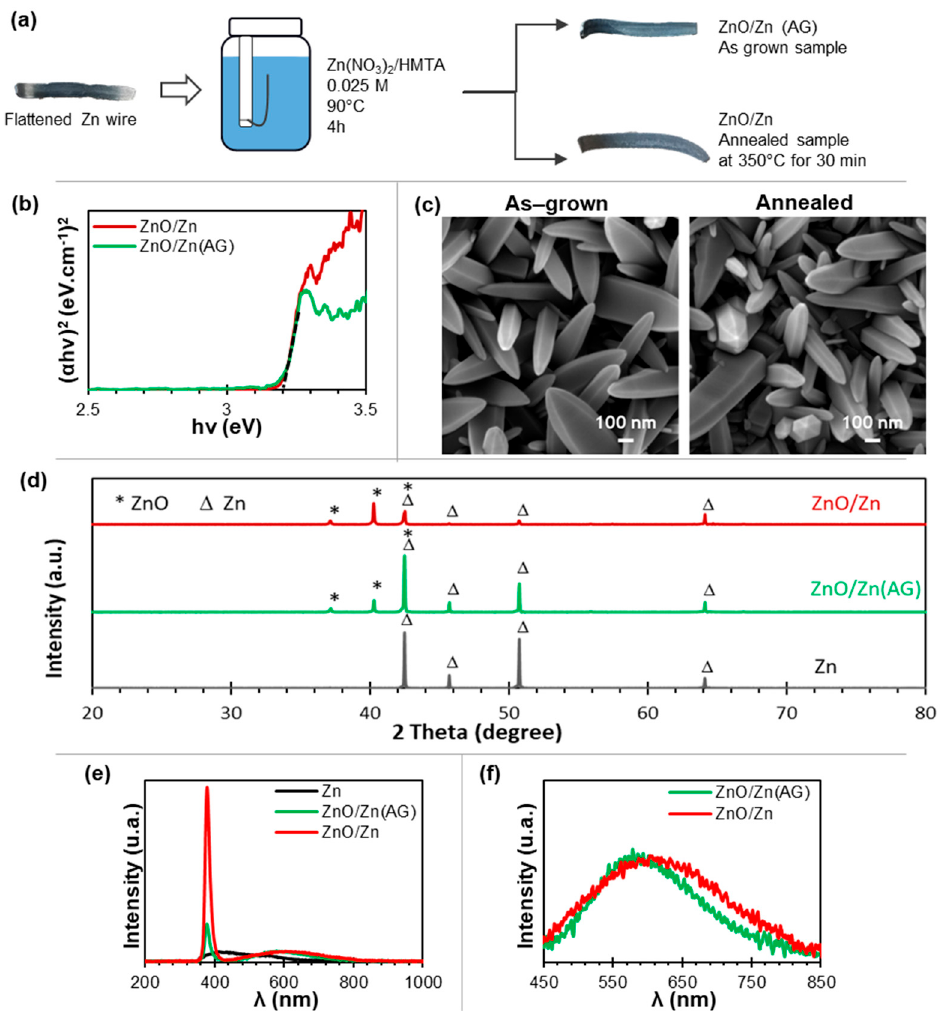
Figure 1. ( a ) Schematic of the experimental set-up for the synthesis of ZnO NSs on flattened Zn wires; ( b ) UV–visible spectral plots according to the Tauc-Lorentz model, ( c ) SEM images and ( d ) XRD patterns of ZnO/Zn(AG) and ZnO/Zn samples, ( e ) PL spectrum of ZnO/Zn(AG) and ZnO/Zn samples, ( f ) PL visible emission band of ZnO/Zn(AG) and ZnO/Zn samples.